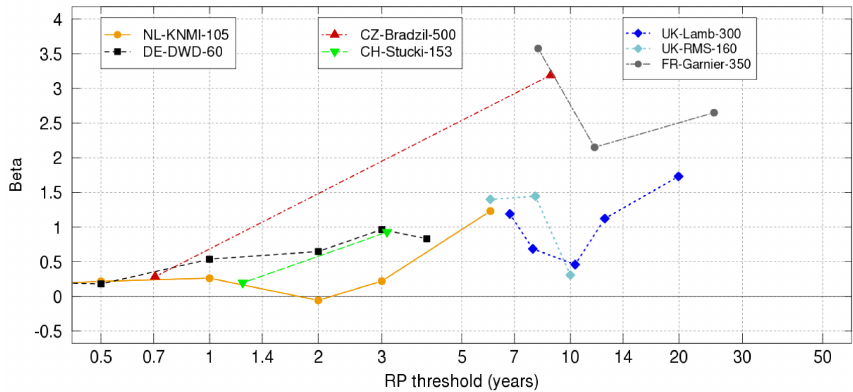
Figure 11. Clustering strength ( β ) versus storm severity from extended historical storm data